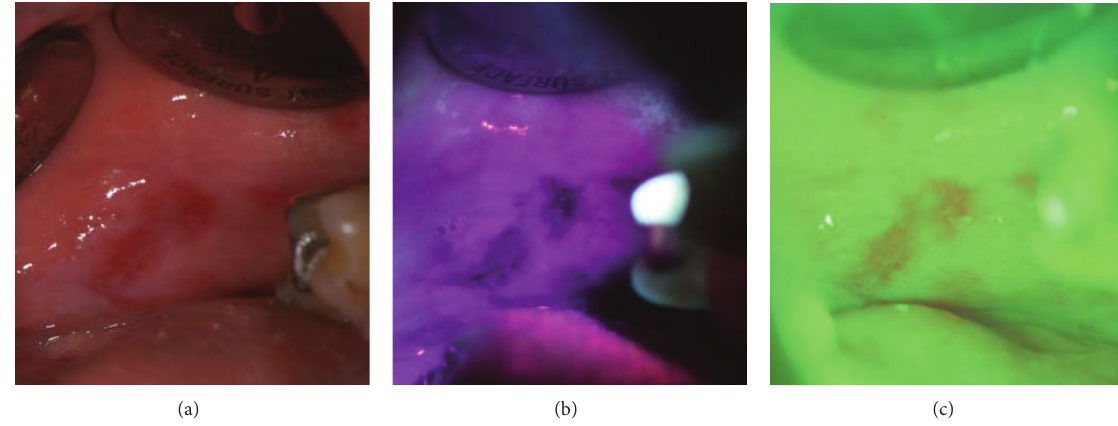
Figure 2: Oral lichen planus on left buccal mucosa visualised with Identafi using its white light feature (a). The same lesion displaying loss of autofluorescence when visualised under violet light with Identafi (b), and microvasculature of the lesion is highlighted with the green-amber light